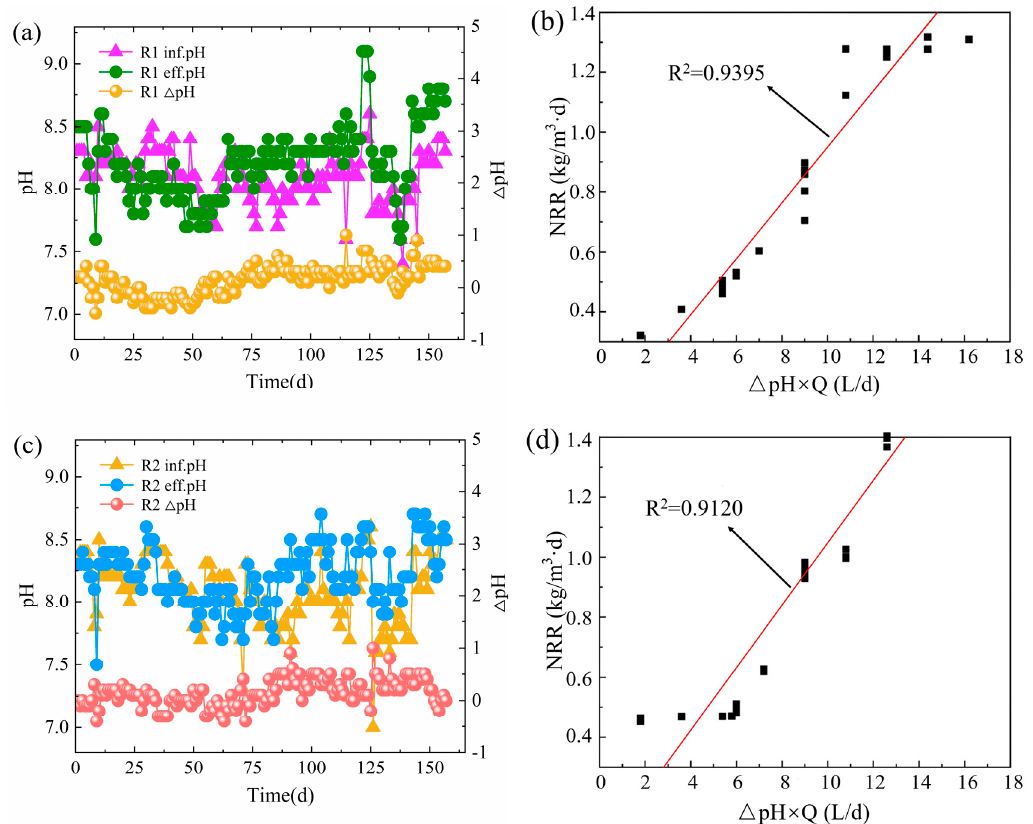
Figure 3. Changes in pH of R1 during start-up ( a ) and its relationship with nitrogen removal (NRR) ( b ); changes in pH of R2 during start-up ( c ) and its relationship with nitrogen removal (NRR) ( d ).